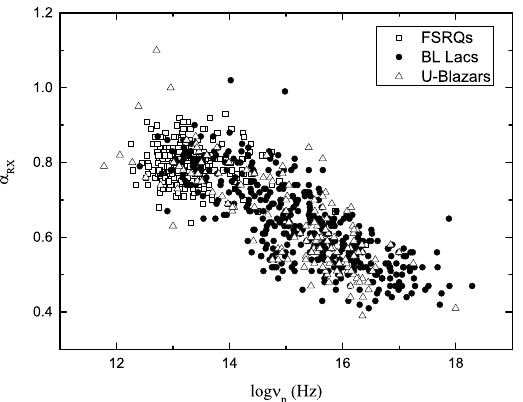
Figure 2. The correlations between spectral index α rx and peak frequency (log ν p ).